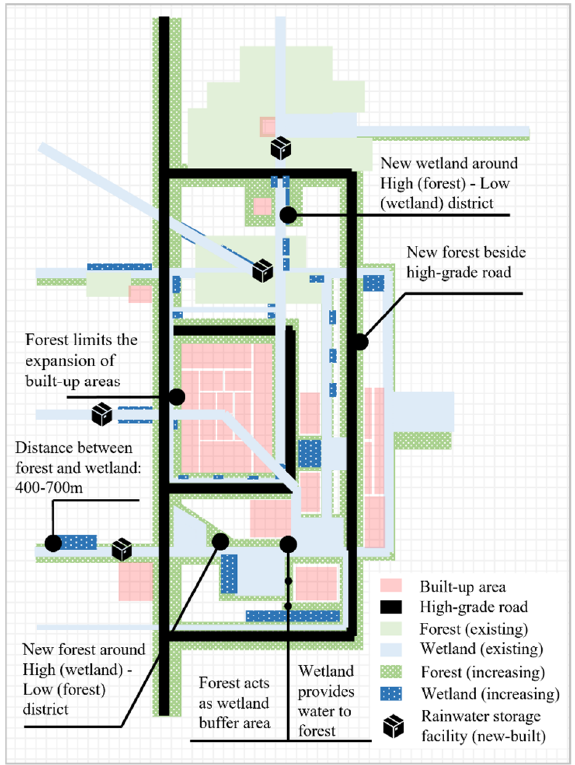
Figure 12. Guidelines of “forest-wetland” spatial planning